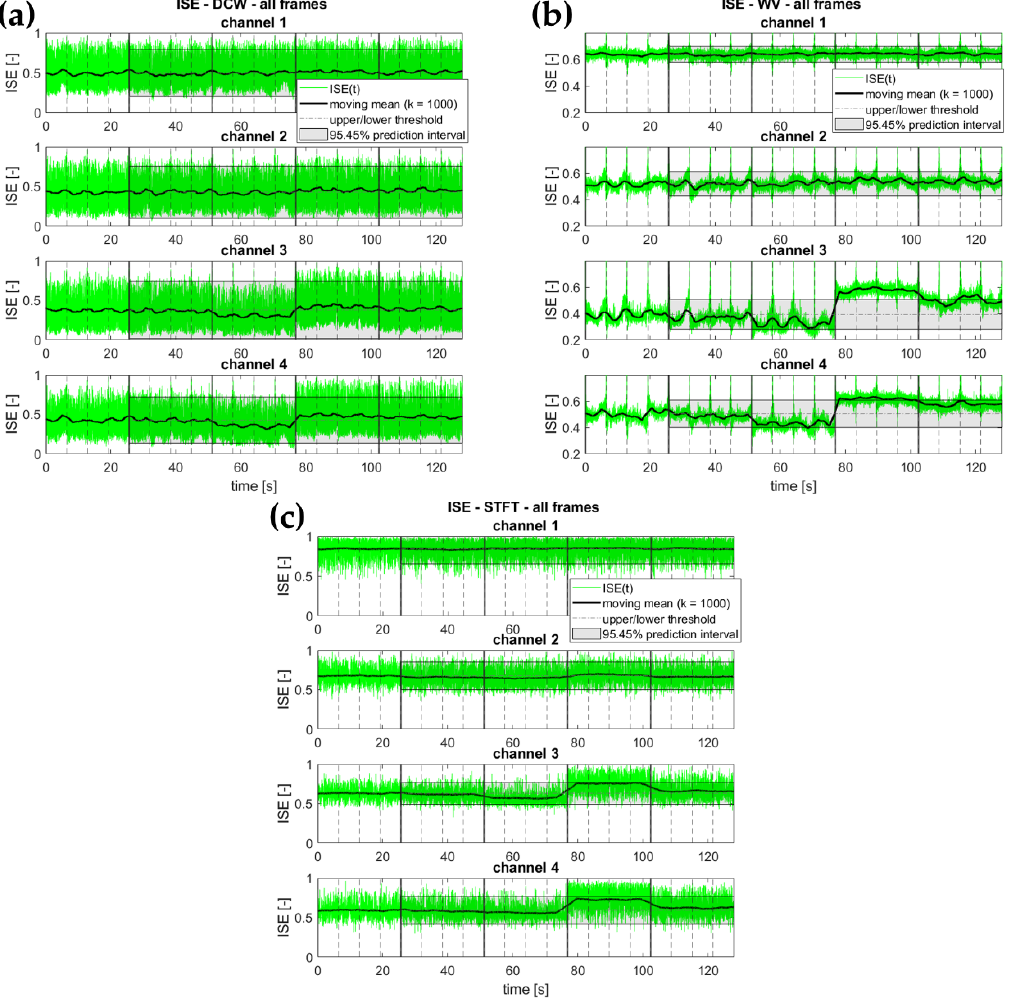
Figure 9. Results for the Wiener entropy. ( a ) Discrete Choi–Williams transform. ( b ) Wigner–Ville transform. ( c ) Short-time Fourier transform.